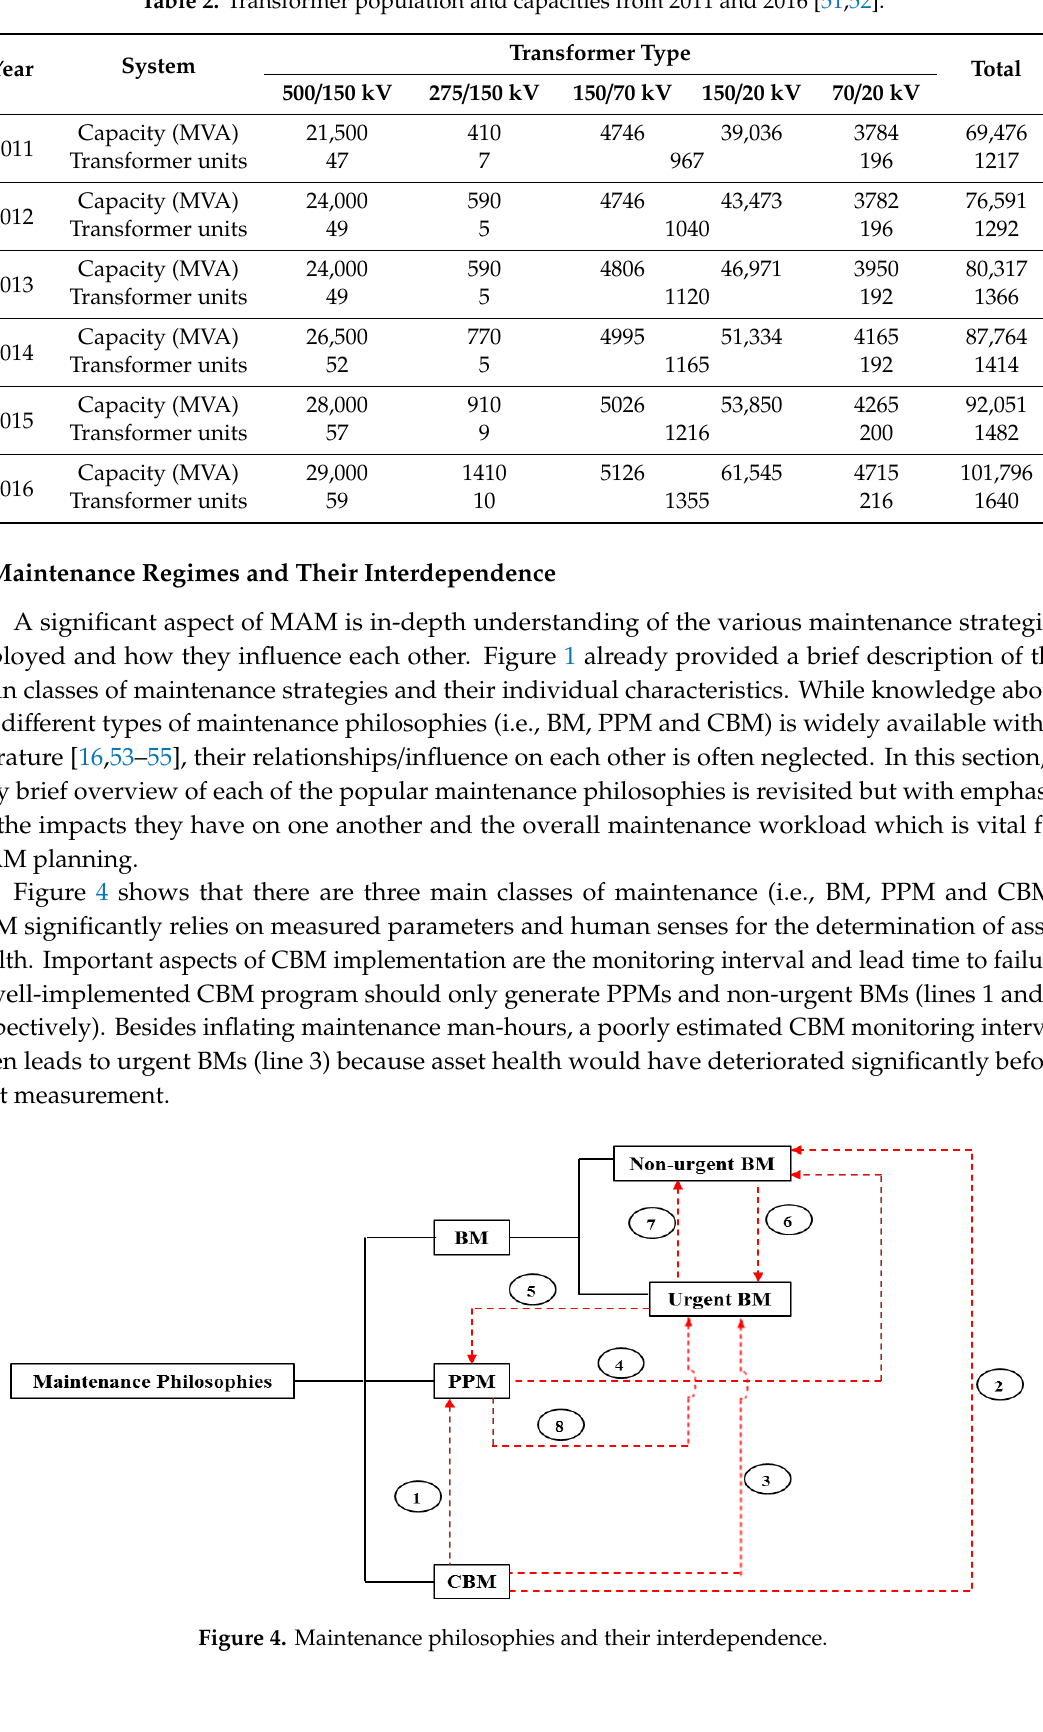
Table 2. Transformer population and capacities from 2011 and 2016 [51,52].